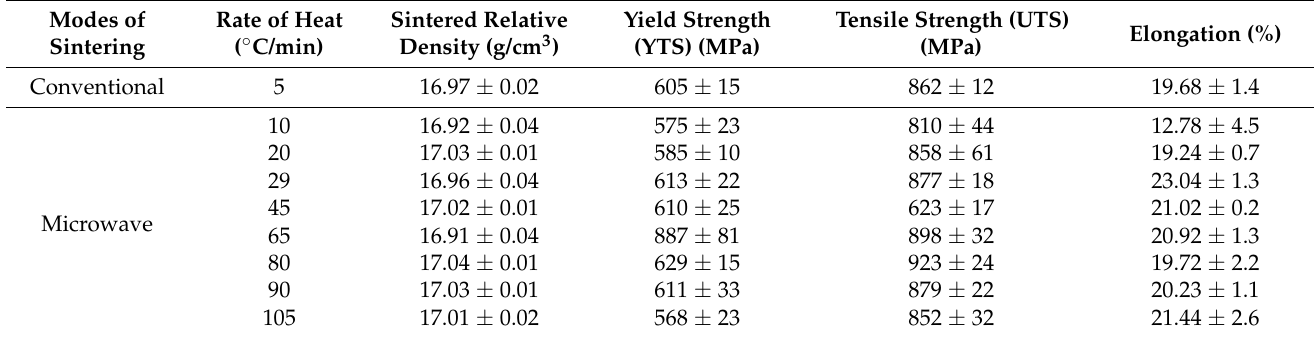
Table 3. Heating rate effects in 90W-7Ni-3Fe-heavy